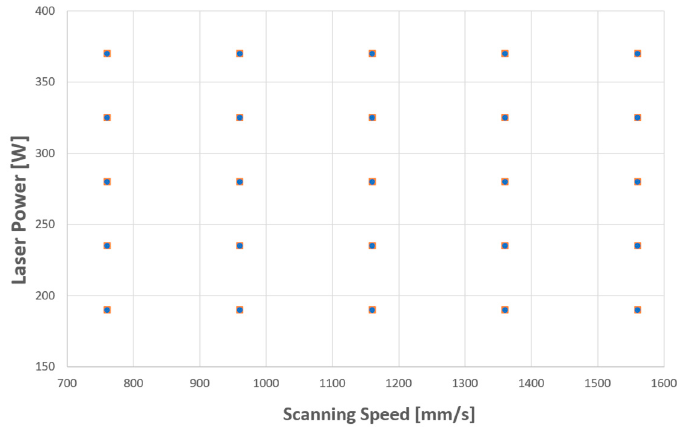
Figure 12. Laser power vs. scanning speed